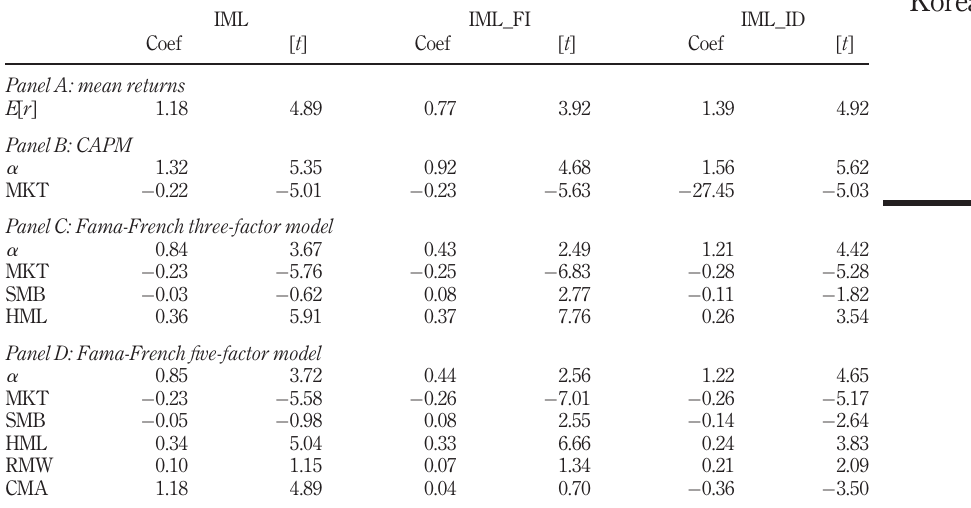
Table 4. Illiquidity factors by investor